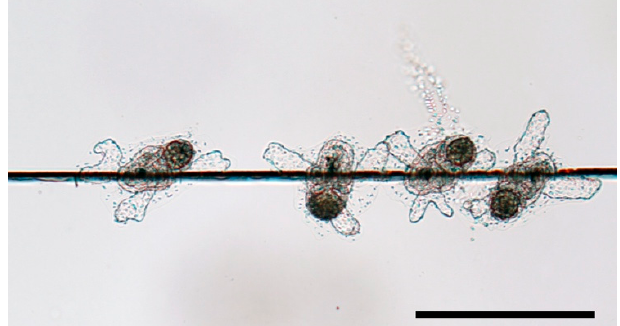
Figure 5. Phallusia philippinensis larvae settling exclusively on the cut line of a SH2CLHF film. Scale bar 1 mm.